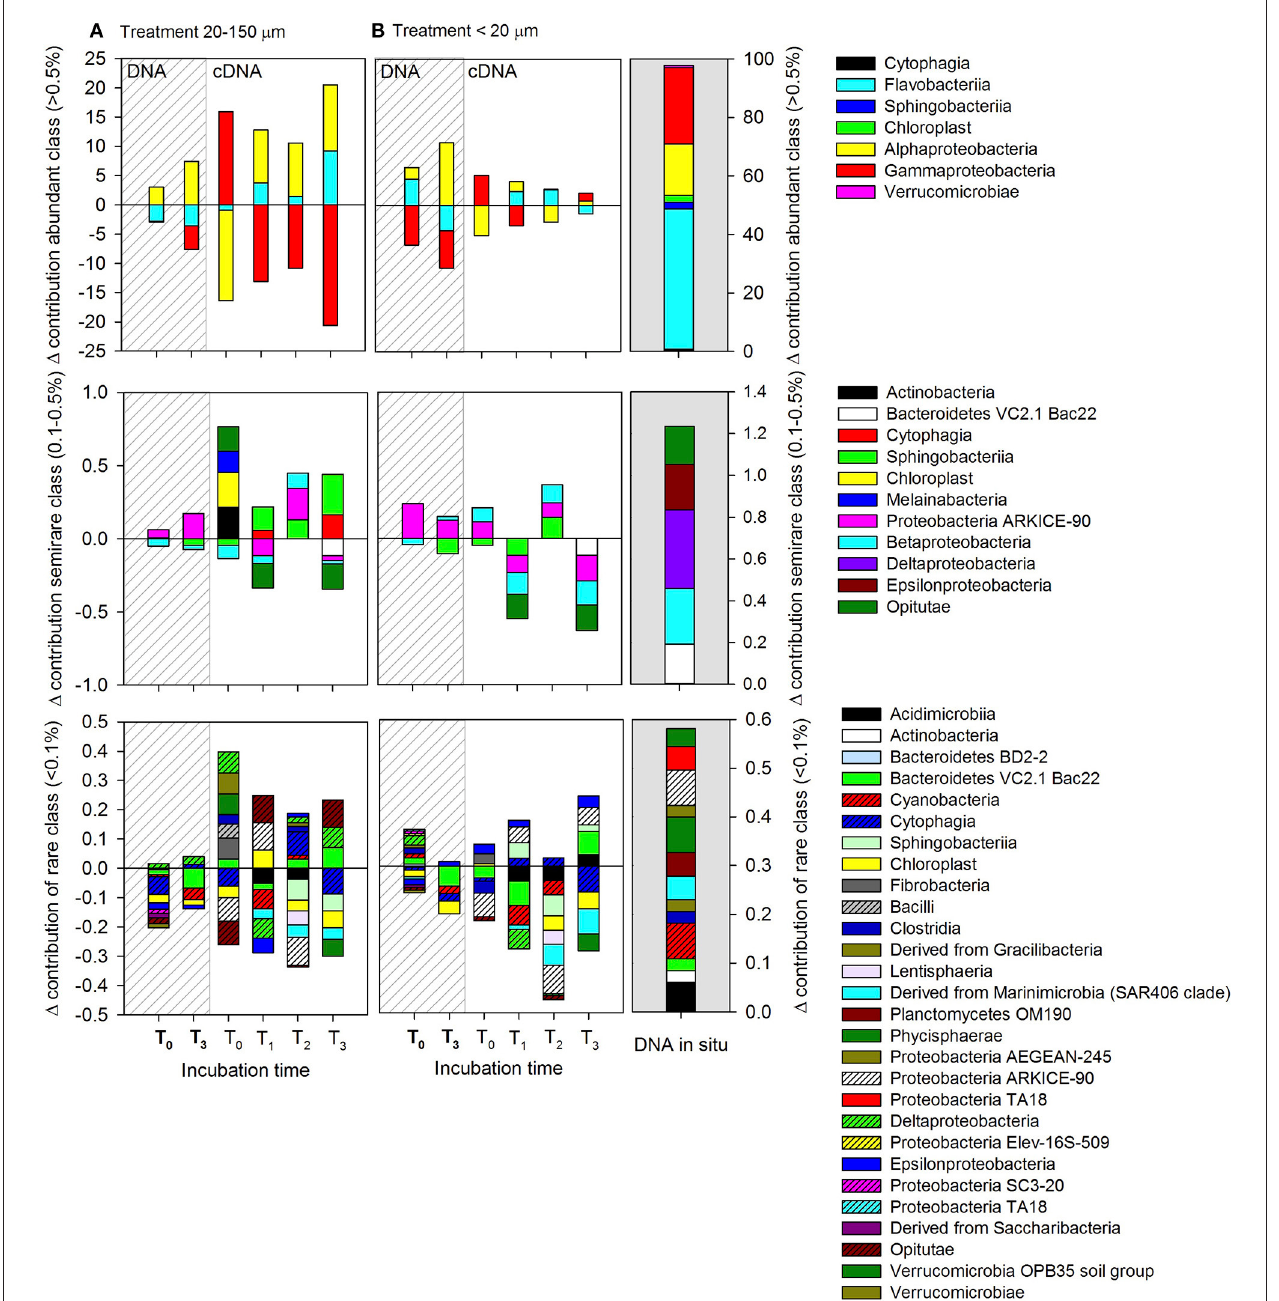
FIGURE 9 | Abundant ( > 0.5%), semi-rare (0.1–0.5%), and rare ( < 0.1%) classes, classified according to their initial in situ contribution throughout the whole incubation period during late summer (March). The relative abundances of each class in the control were subtracted from the treatments. Positive values indicate a higher presence in treatments than in the control, and vice versa for negative values. (A) Treatment inoculated with dissolved compounds excreted by copepods fed with the 20–150- µ m size-fraction diet, and (B) treatment inoculated with dissolved compounds excreted by copepods fed with the < 20- µ m size-fraction diet. The dashed lines indicate the composition of the total bacterial community